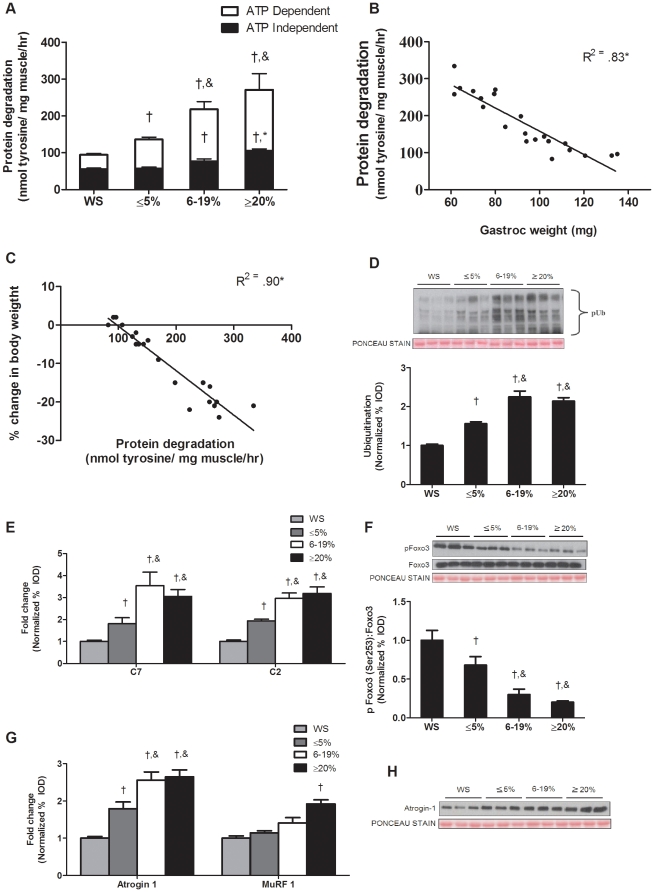
Skeletal muscle protein degradation consists of ATP dependent and independent mechanisms during the progression of cachexia in the ApcMin/ mice.Protein degradation was measured in ApcMin/+ mice with progressive body weight loss. A) Protein degradation determined by tyrosine release assay. White bars represent ATP dependent degradation; Black bars represent ATP independent degradation. B) Correlation between protein degradation and gastrocnemius weight. C) Correlation between protein degradation and the percentage of body weight loss. D) Upper representative western blot of ubiquitinated proteins in the gastrocnemius muscle. Lower Quantification of ubiquitinated proteins normalized to weight stable ApcMin/+ mice. E) Gene expression of C7 and C2 proteasomal subunits. F). Upper: representative western blot of phosphorylated and total forms of Foxo3. Lower: The ratio of phosphorylated and total Foxo3. G) Gene expression of atrogin1 and MuRF1. H) Representative western blot of atrogin1 protein. Values are means ± SE. Significance was set at p<0.05. † Signifies different from WS groups. & Signifies difference from mice with ≤5% body weight loss. WS, weight stable.